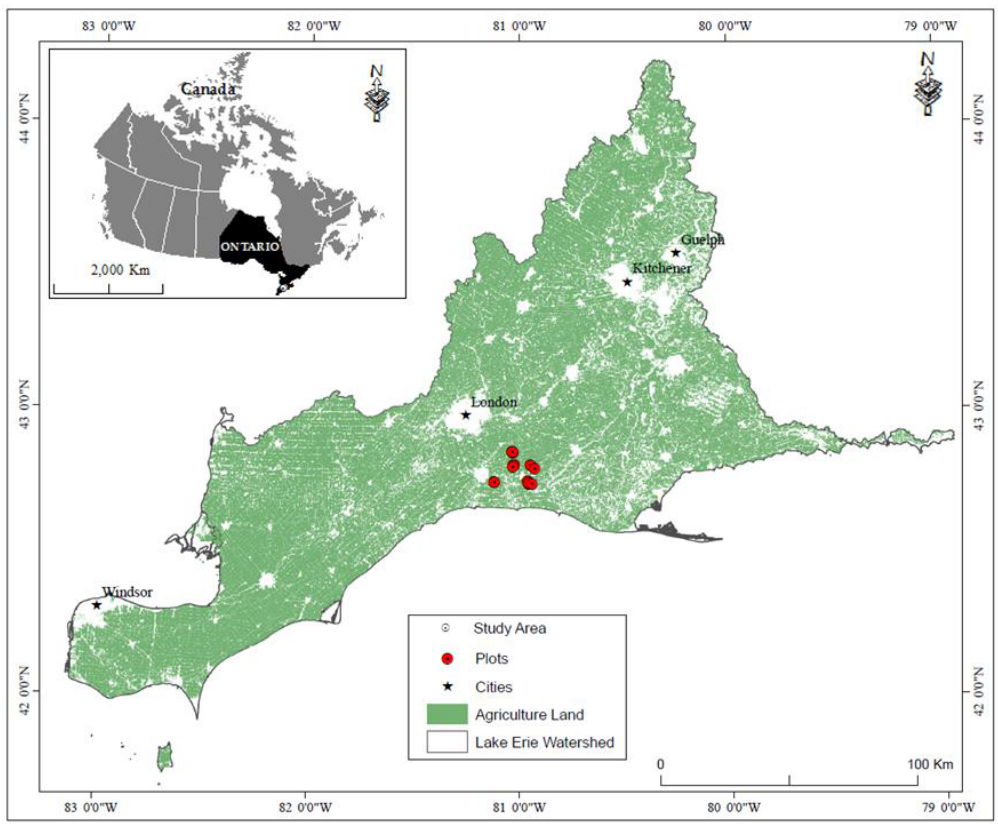
Figure 1. Study area within the Lake Erie watershed, southern Ontario, Canada. The 18 plots used in this study were located south of the city of London.